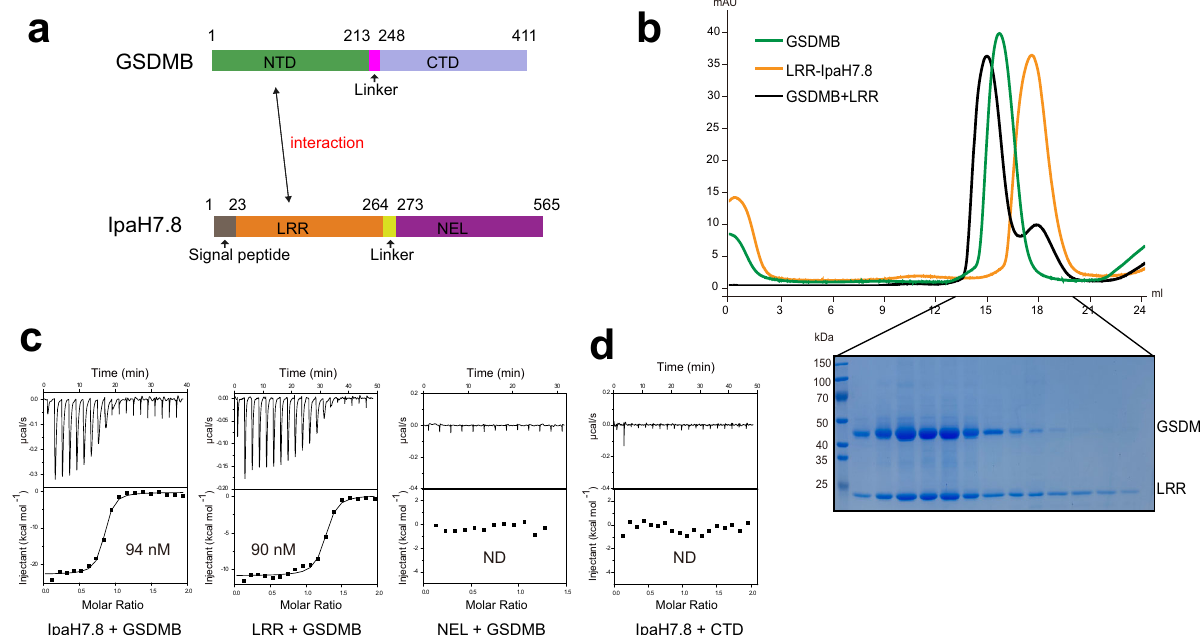
Fig. 1 | IpaH7.8 binds to GSDMB. a Domain organization of GSDMB and IpaH7.8. NTD N-terminal domain, CTD C-terminal domain, LRR leucine-rich repeat domain, NEL novel E3 ligase domain. b Superimposed gel- fi ltration pro fi les of GSDMB, LRR and GSDMB-LRR complex. Shown on the bottom is SDS-PAGE analysis of the